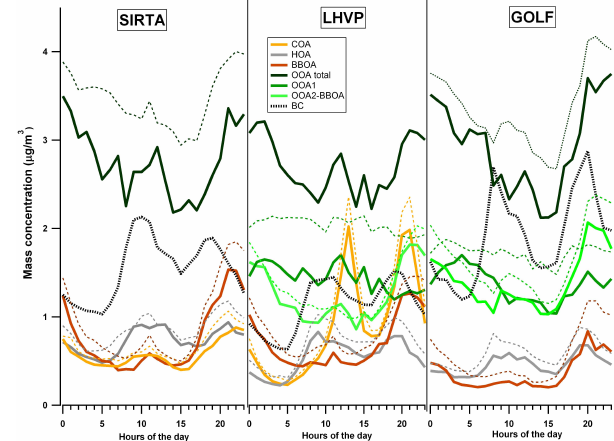
Fig. 8. Diurnal patterns of the PMF factors (solid line = median values, dashed line = mean values). For comparison, the OOA total, which represents the sum of OOA 1 and OOA 2 -BBOA when these two sources were identified separately by PMF, is